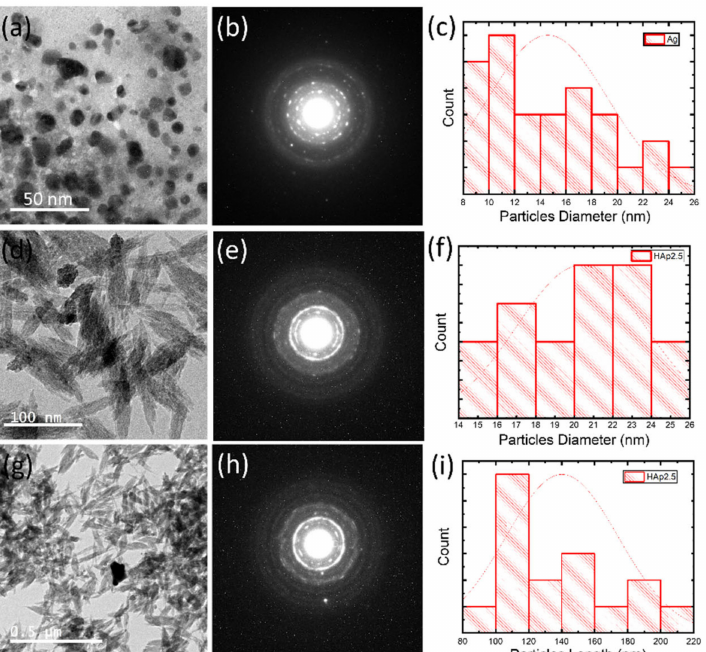
Figure 8. Representative transmission electron microscopy (TEM) images of the prepared nanoparticles and their corresponding selected area electron diffraction images and particle size distribution: ( a – c ) Ag NPs; ( d – f ) HAp2.5 NPs; ( g–i ) Ag-HAp2.5 NPs. In the histograms change into Particle Diameter.